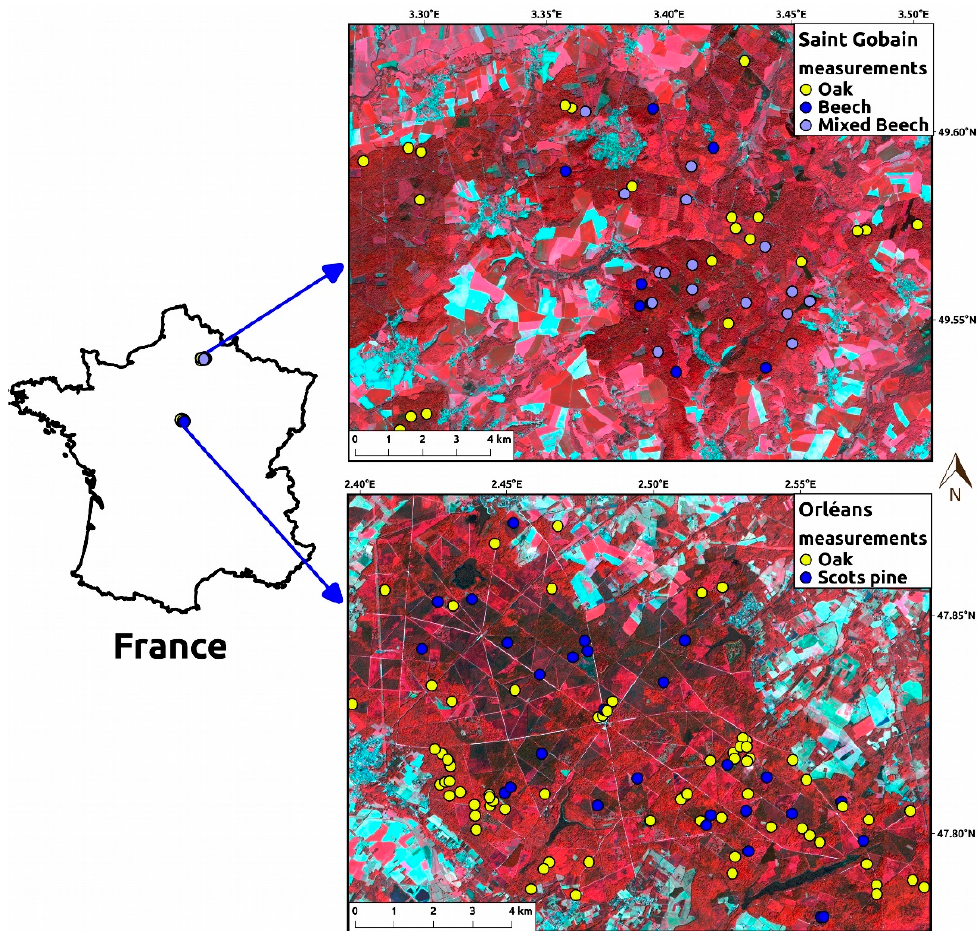
Figure 1. Study sites in the north of France. Measurement plots are shown on both sites, background images are Sentinel-2 2016 summer dates in false colours (active vegetation appears in red).